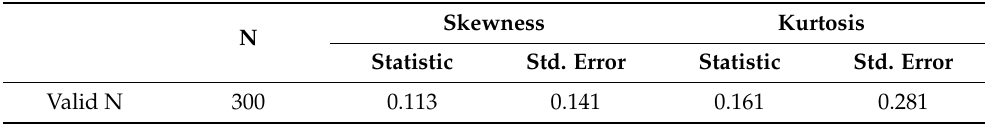
Figure 3. Histogram of the aspect ratio of OBB ( X -axis represents the aspect ratio of OBB per maize plant). Table 2. Normality tests: skewness and